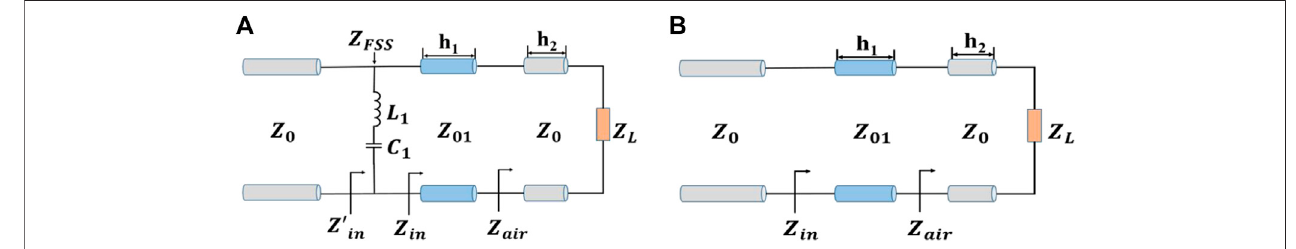
FIGURE 4 | Equivalent circuits of the 1-bit polarization conversion unit cell (A) with substrates and (B) with an FSS.